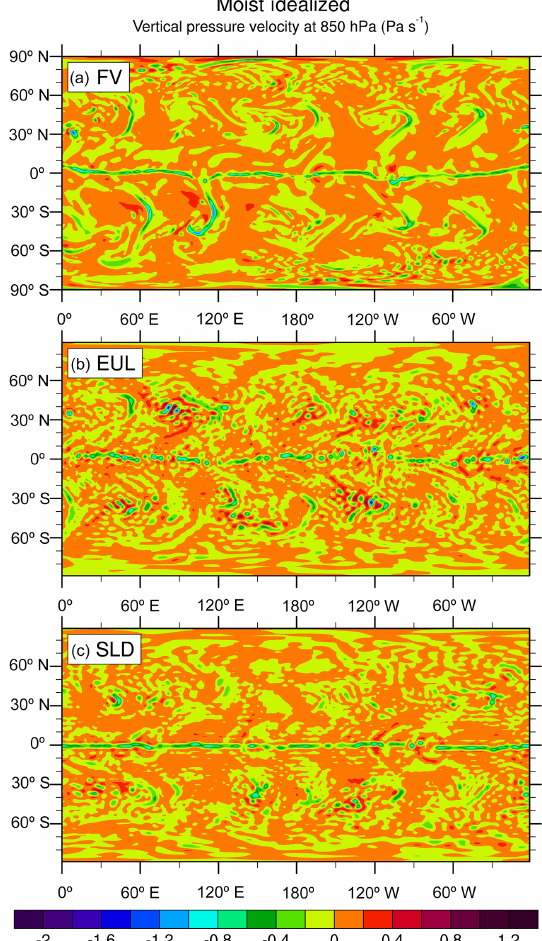
Figure 10. Instantaneous latitude–longitude snapshots of the 850hPa vertical pressure velocity in MITC simulations with (a) FV, (b) EUL, and (c)